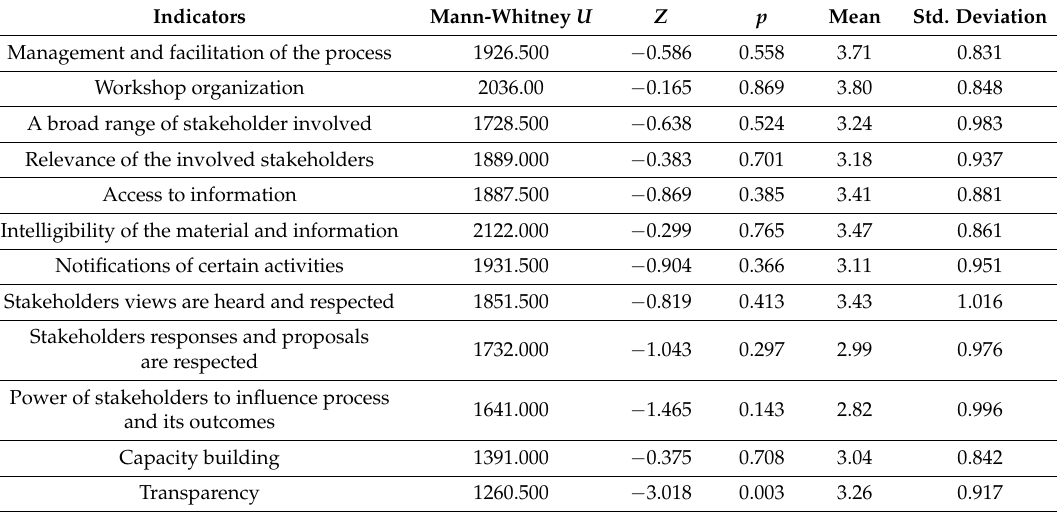
Table A2. Statistic results of Indicators for an Effective Participatory